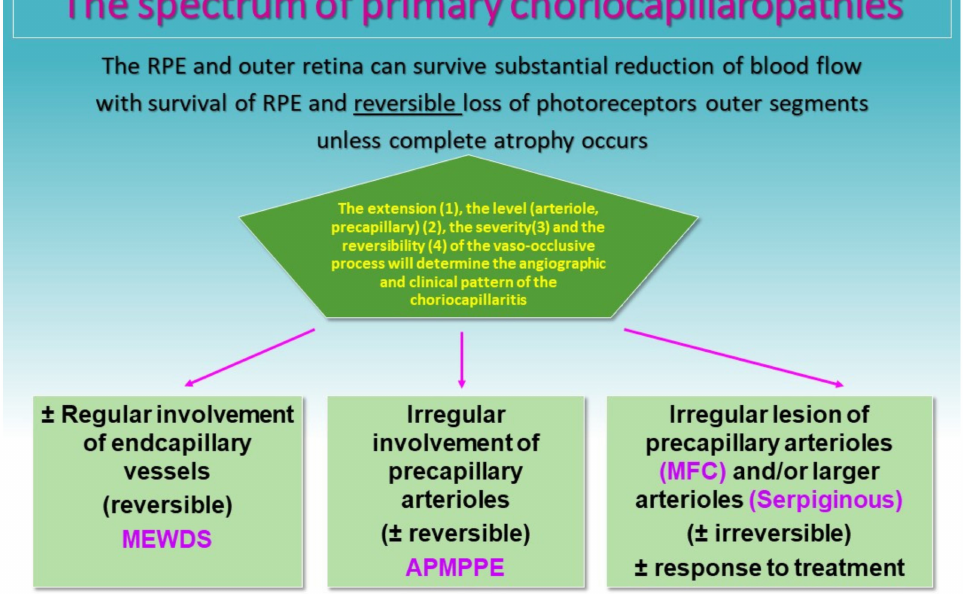
Figure 7. Clinicopathology of PICCPs according to the suspected type and extension of vessel non-perfusion. Non-perfusion of low-flow endcapillary vessels cause the benign and reversible disease MEWDS. If larger choriocapillaris vessels or precapillary vessels are occluded the more severe diseases develop including APMPPE, MFC and